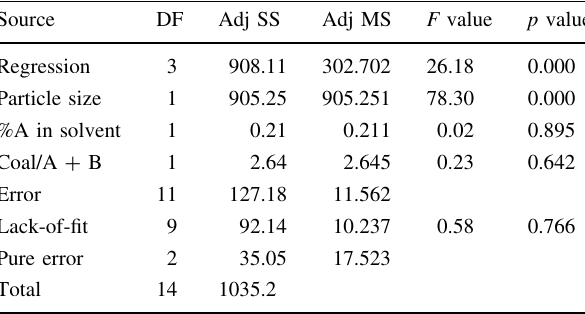
Table 12 Analysis of variance model regression on extraction yield